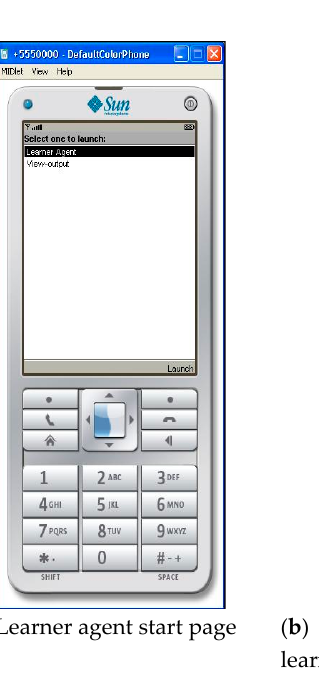
Figure 11. Proposed architectural design for collaborative mobile learning multi-platform using JADE-LEAP.